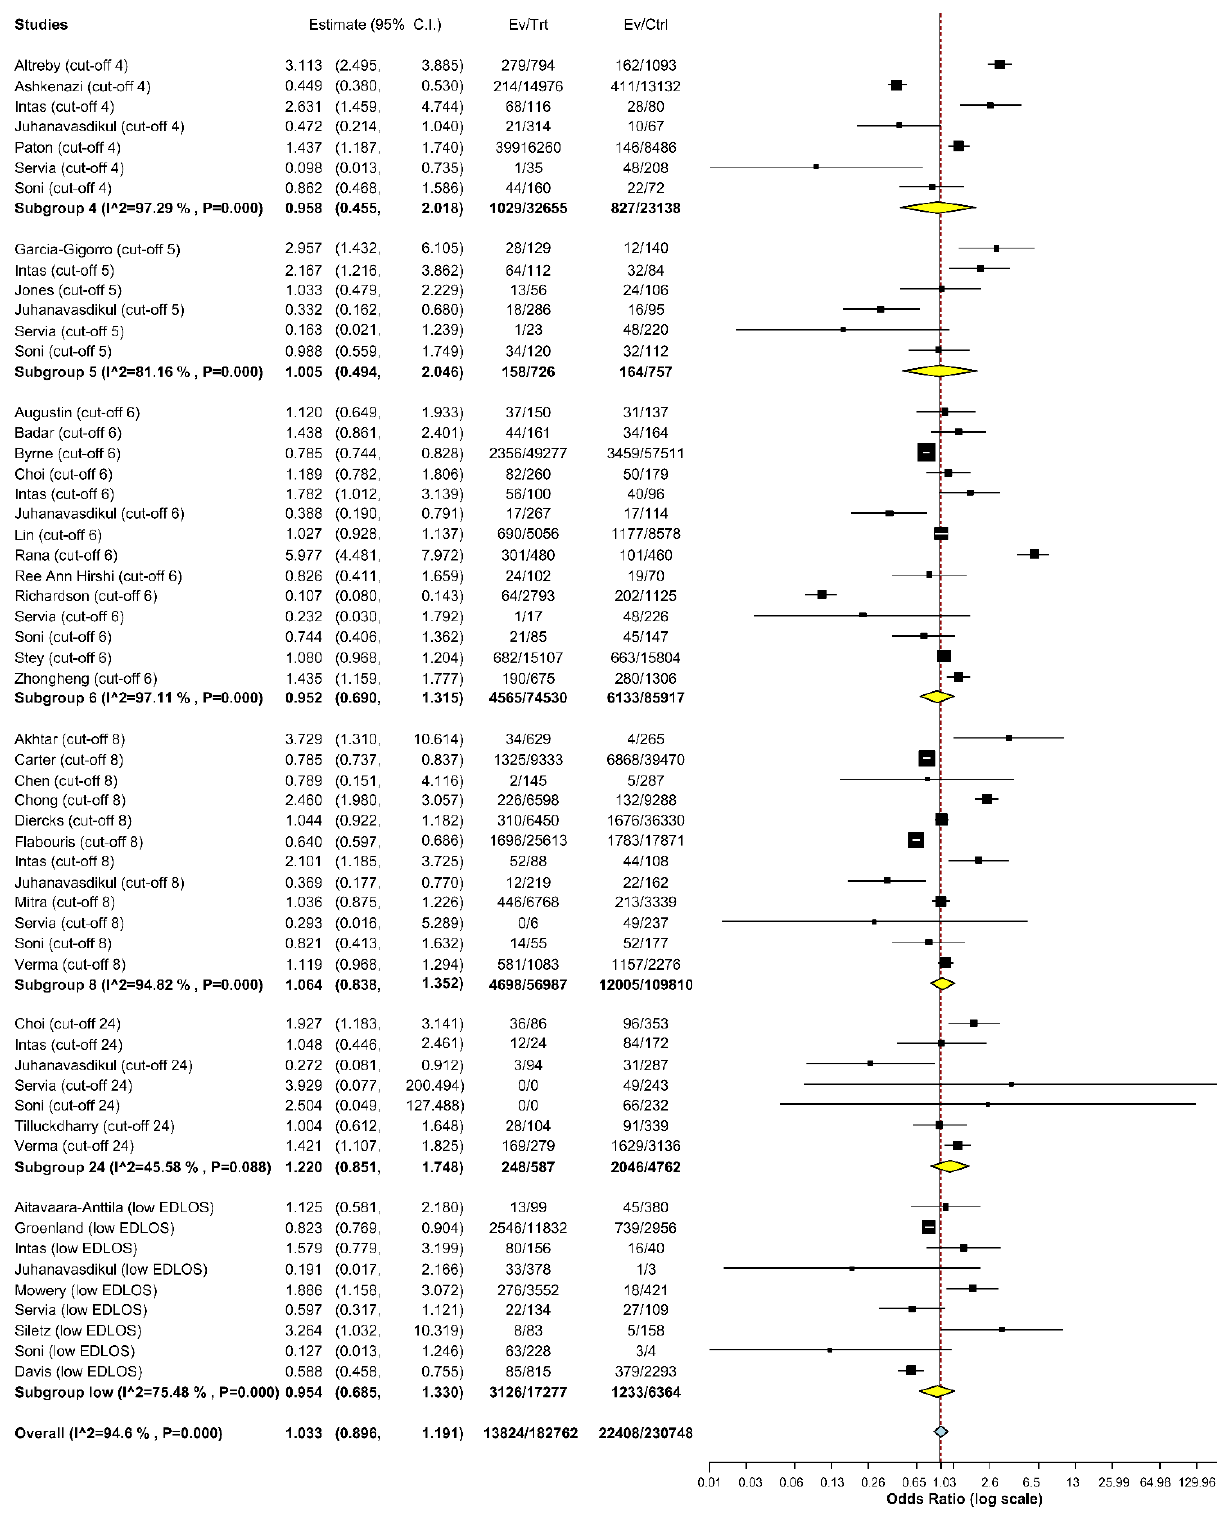
Figure 3. Meta-analysis including studies with the same EDLOS (1.2 h, 1.5 h, 2h , 3 h cut-offs), 4 h, 5 h, 6 h, 8 h, and 24 h cut-offs using the DerSimonian–Laird random effects model). I ^ 2 = I 2 . EDLOS, emergency department length of stay. emergency department length of